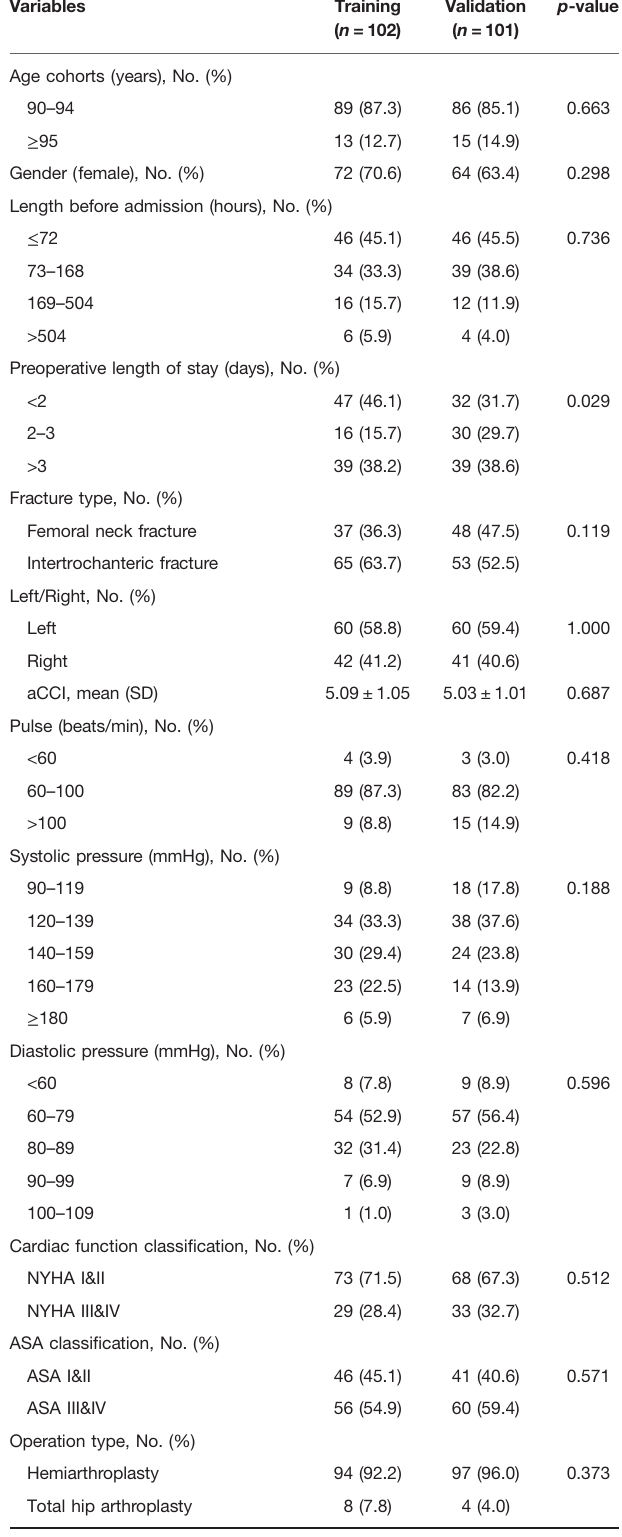
TABLE 2 | Demographic and clinical characteristics of the included nonagenarians with hip fracture.